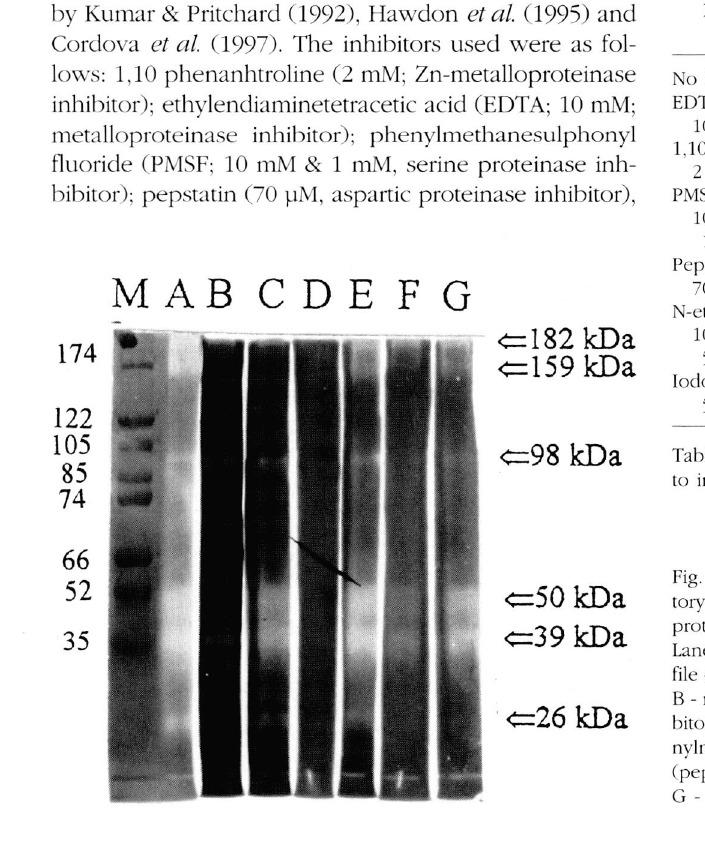
Fig. 1. - Characterization of gelatinolytic proteinases in the excre­ tory-secretory products (ESP) of adult Uncinaria stenocephala using proteinase inhibitors. Lanes: M - molecular weight markers (kDa); A - the SDS-PAGE